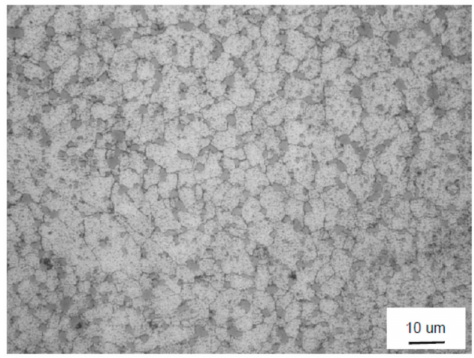
Figure 4. Representative microstructure of the solution-annealed (CP T6)